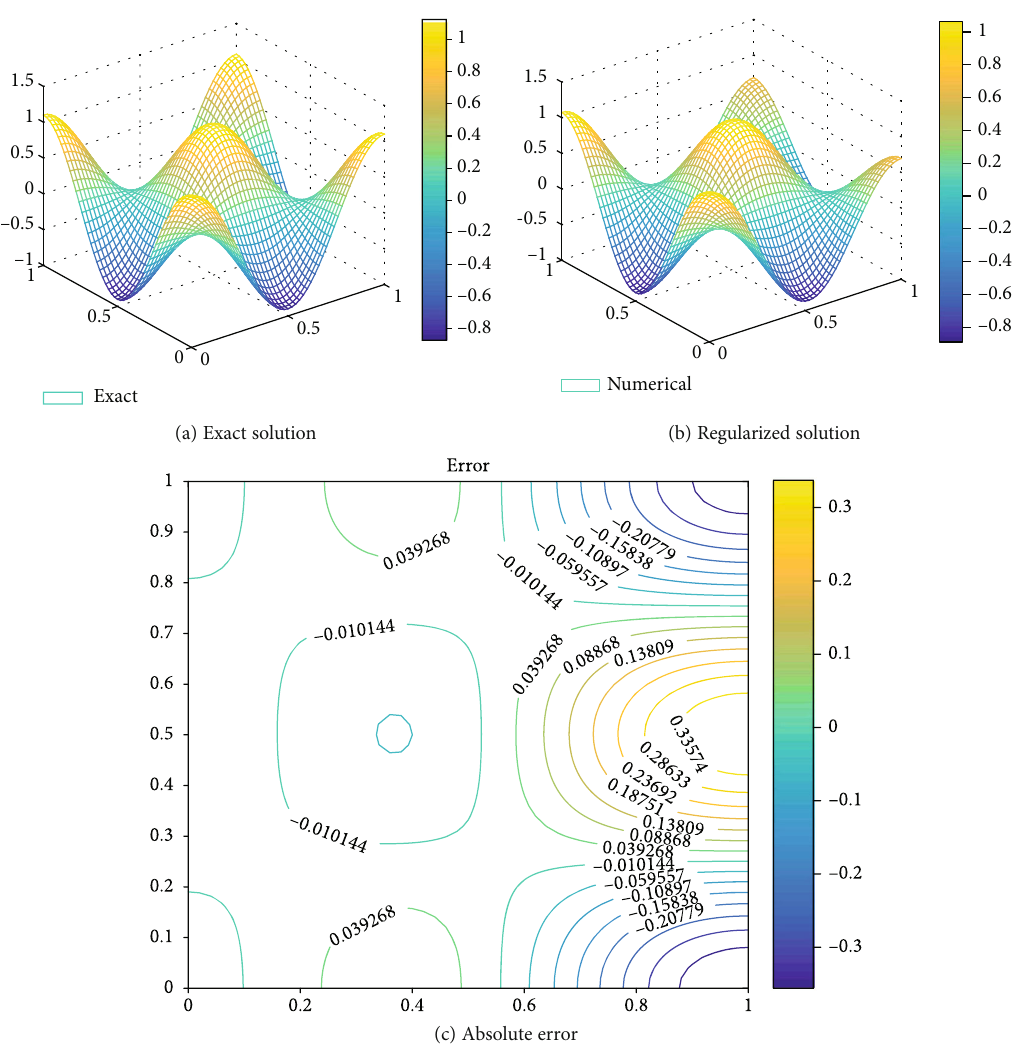
Figure 4: The numerical results for Example 18 for α = ð 0 : 6,0 : 5,0 : 4 Þ with μ = 0 : 01 δ 3/4